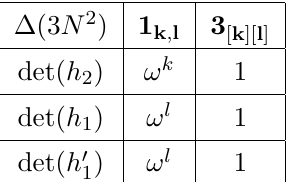
and h 2 simply denote the 1